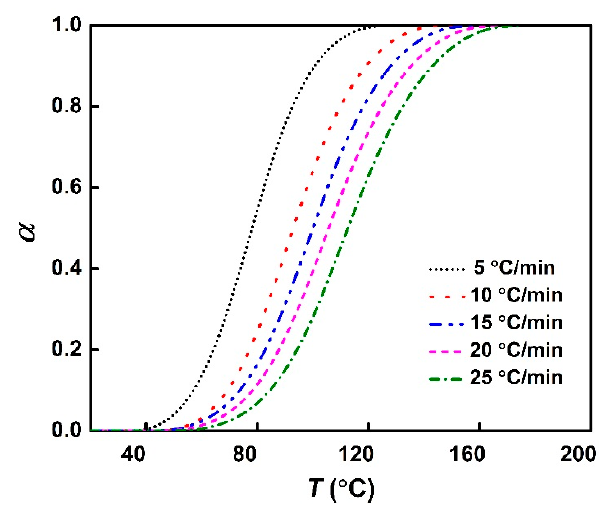
Polymers 2019 , 11 , x FOR PEER REVIEW Figure 5. Conversion vs. temperature at different heating rates for the phenolic amine / epoxy resin system. Figure 5. Conversion vs temperature at different heating rates for the phenolic amine/epoxy resin system.